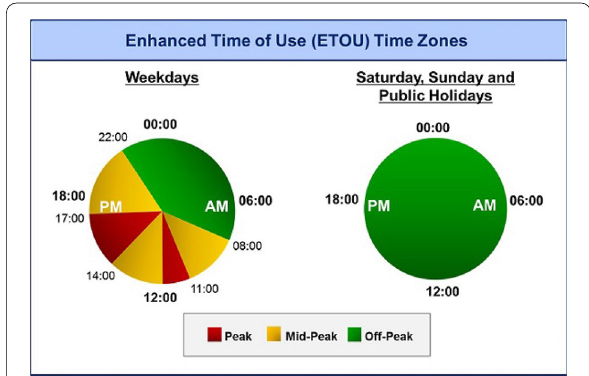
Fig. 2 Tenaga National Berhad enhanced time of use of electricity (TNB ENHANCED TIME OF USE (ETOU)